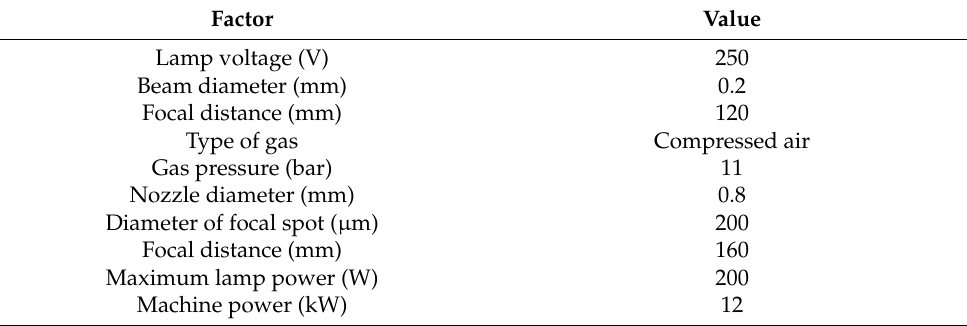
Table 1. Factors that were not varied during the